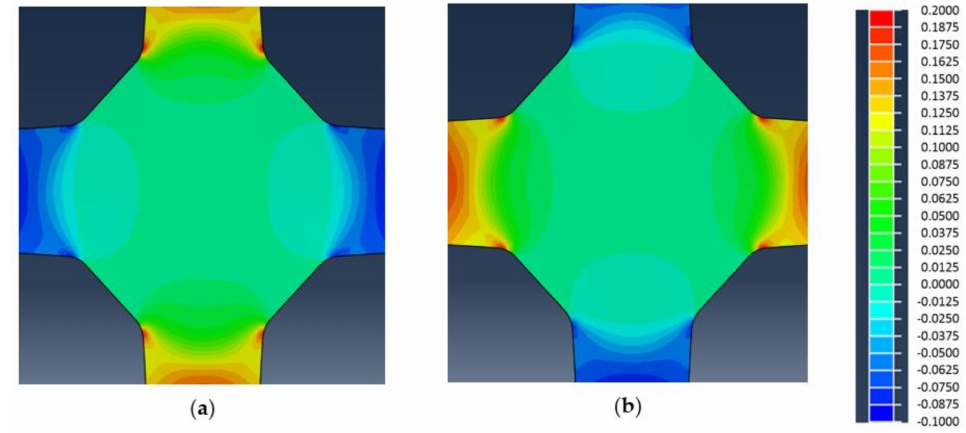
Figure 14. In-plane strain for Specimen_0: ( a ) ee11—strain component, ( b ) ee22—stress component. The analyzed area of the sample underwent plastic deformation only in the final stage of the biaxial stretching process and the registered strain level is very low (Figure 15).